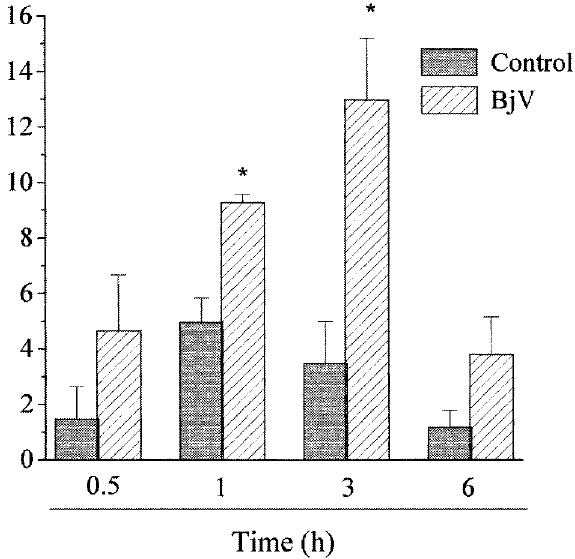
FIG. 3. Release of IL-6 induced by BjV. Animals received i.p. injection of BjV (250 m g/kg) or sterile saline (control). The concentrations of IL-6 in the peritoneal wash was evaluated by enzyme immunoassay 0.5, 1, 3 and 6h after injection. Values represent the mean ± SEM from five or six animals. * p < 0.01 compared with control.